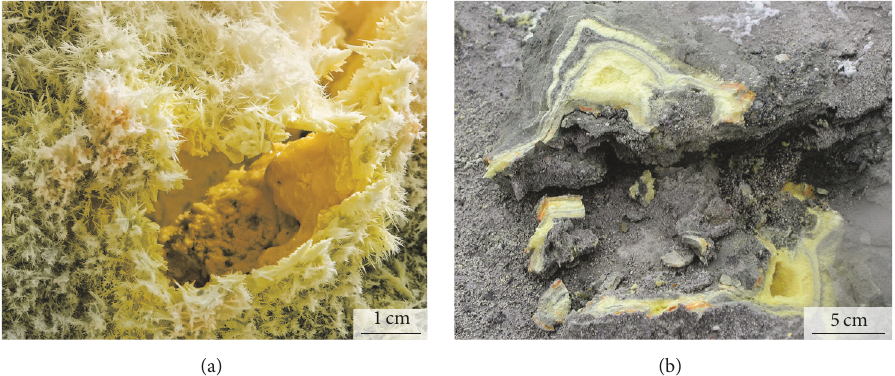
Figure 3: (a) Acicular sulfur crystals deposited from fumarolic gas; a gas channel covered with molten sulfur is visible. (b) Layered sulfur deposits of different colors around a fumarolic vent. The red color is due to arsenic and the greenish-gray color is due to dispersed pyrite crystals. South field, Ebeko volcano. Photos by M.